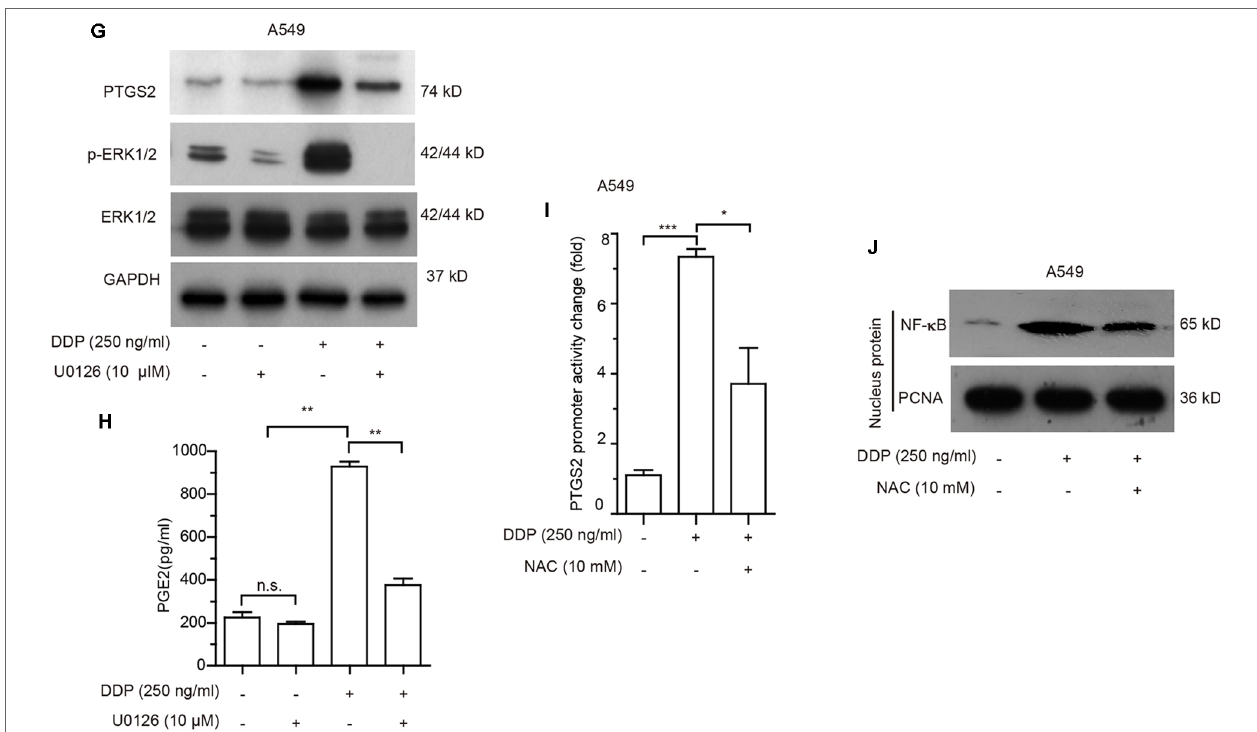
FIGURE 4 | Cisplatin induced PTGS2 via reactive oxygen species (ROS) mediated ERK1/2-NF κ B pathway. (A) Cells were treated with cisplatin and subjected to analysis of PTGS2 expression by Western blotting, as well as PGE2 generation by ELISA as described in the Materials and Methods. (B) Cells seeded in 6-well plates were treated with cisplatin for the indicated times, and subjected to detection of the levels of reactive oxygen species (ROS) by flow cytometry. Values were expressed as the means ± SEM of three separate experiments. (C) Cells were plated at a density of 5 × 10 5 /well in 6-well plates and treated with cisplatin for 24 and 48 h prior to immunoblot analysis of ERK1/2 activation. (D – F) Cells were treated with 10 mM NAC for 6 h before stimulation with cisplatin, and subjected to detection of the levels of reactive oxygen species (ROS) by flow cytometry, expressions of PTGS2 and the activation of ERK1/2 by Western blot analysis, and PGE2 generation by ELISA. (G and H) A549 cells were treated with 10 μM U0126 for 12 h before stimulation with 250 ng/ml cisplatin, followed by detection of PTGS2 expression and ERK1/2 activation by Western blotting, as well as PGE2 generation by ELISA. (I and J) Cells were treated with 10 mM NAC for 6 h prior to stimulation with 250 ng/ml cisplatin and subjected to detection of the PTGS2 promoter activity and NF- κ B translocation by flow cytometry and Western blot analysis, respectively. * P < 0.05, ** P < 0.01, *** P < 0.001 and “n.s.” means “no significance.” The loading of each compartment in immunoblot analysis was indicated by GAPDH (cytoplasmic) and PCNA